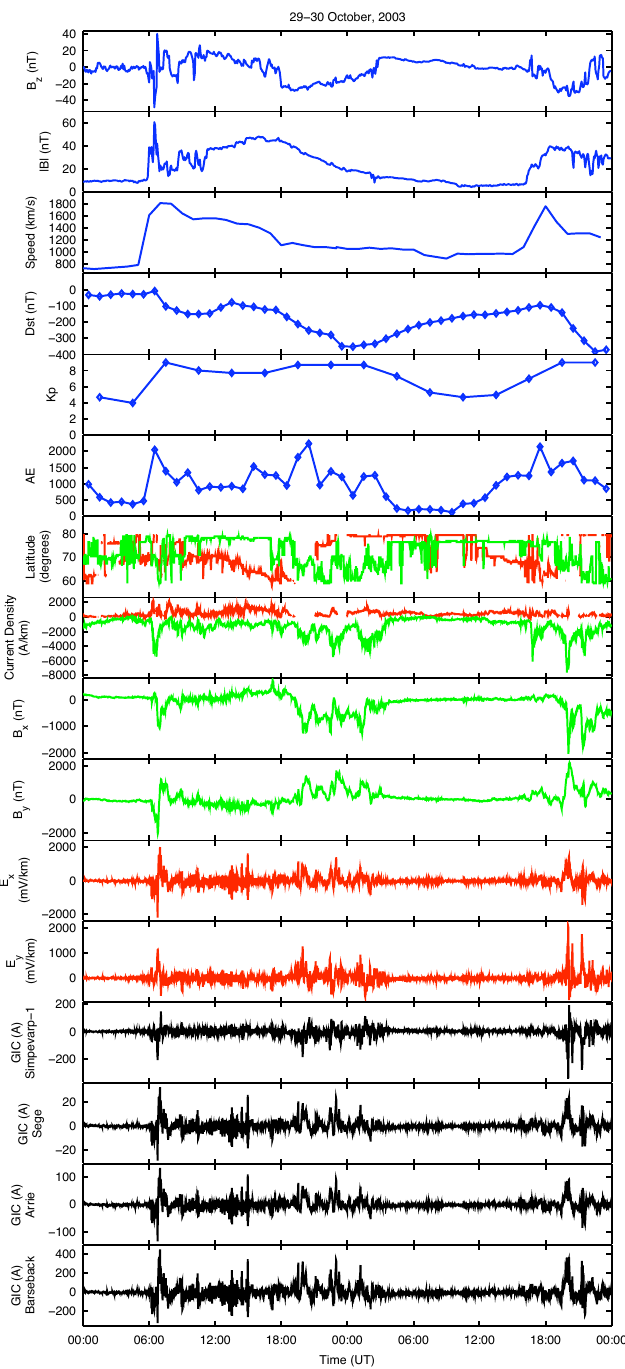
Fig. 7. Stack plot of ACE solar wind data, geomagnetic indices, electrojet parameters, horizontal geomagnetic and geoelectric data and geomagnetically induced currents for 29–30 October, 2003. The three top panels show the solar wind B z component and magnetic field magnitude | B | from ACE/MAG and the helium ion bulk speed from ACE/SWICS. The next three panels present the D st , K p and AE indices. The calculated latitude and intensity for the eastward (red) and westward (green) electrojets are shown in the next two panels. Interpolated geomagnetic and calculated geoelectric data depicted in the following four panels refer to the more southern red grid point in Fig. 1. The four bottom panels present calculated GIC at Simpevarp-1, Sege, Arrie and Barseb¨ack (stations # 20, # 18, # 1 and # 3 in Fig. 2).